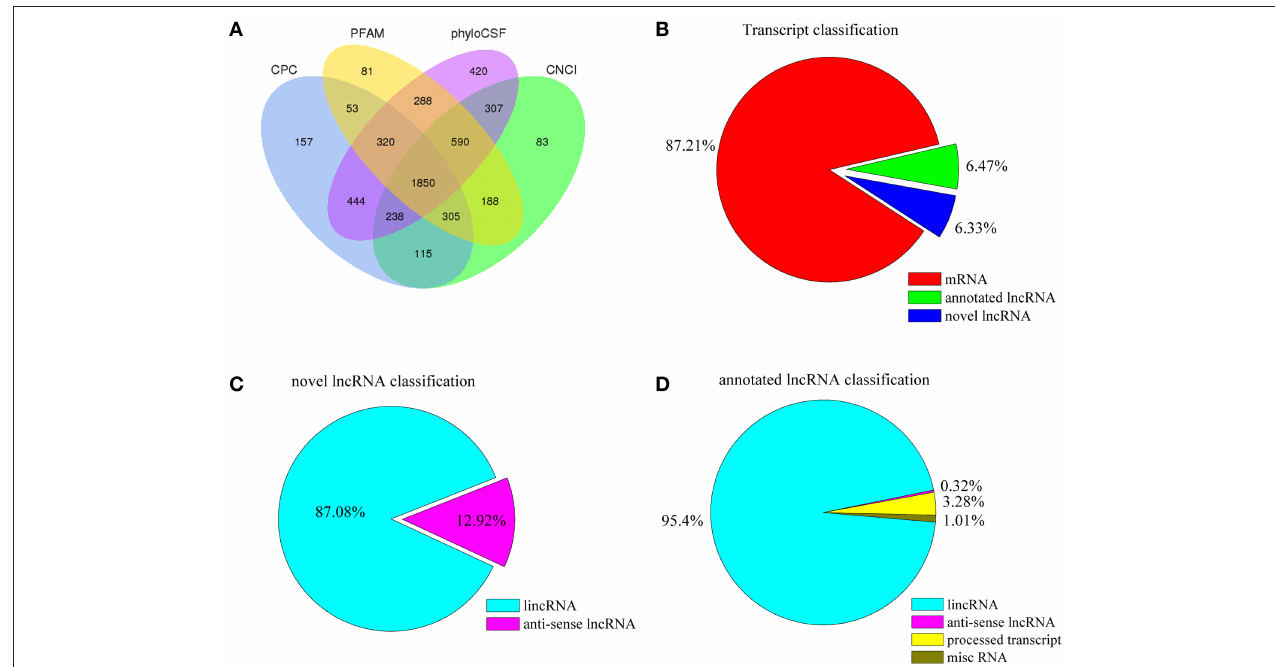
FIGURE 2 | (A) Identification of 1,850 putative lncRNAs without protein-coding potential evaluated by CPC, PFAM, phyloCSF, and CNCI. (B) Classification of lncRNAs, (C) novel lncRNAs, (D) annotated lncRNAs, and mRNAs identified in piglet ileums by RNA-seq.